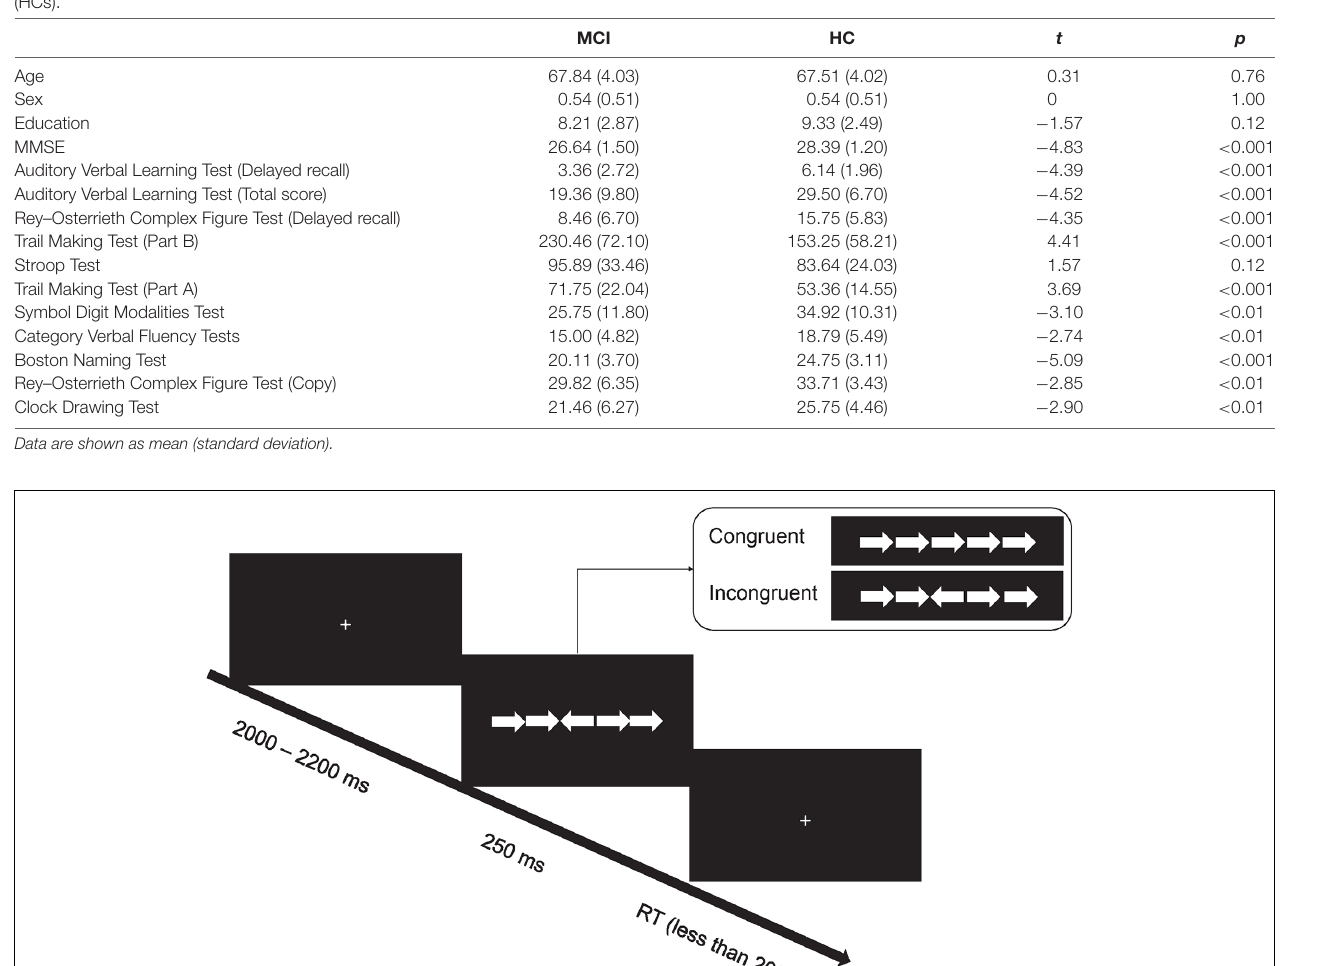
pointing to either the left or the right, against a black background ( Figure 1 ). We manipulated the congruency of arrow direction: congruent (the central target pointed to the same direction as the flankers) vs. incongruent (the central target pointed to the opposite direction as that of the flankers). At the